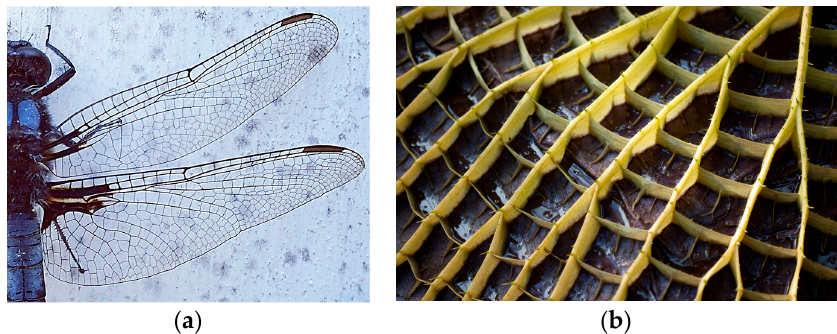
Figure 11. Branching patterns in dragonfly ( a ) and the Amazon water lily ( b ) demonstrate how tessellation can be defined in the context of branches (Attr: lily by Laitr Keiows, Wikimedia Commons).